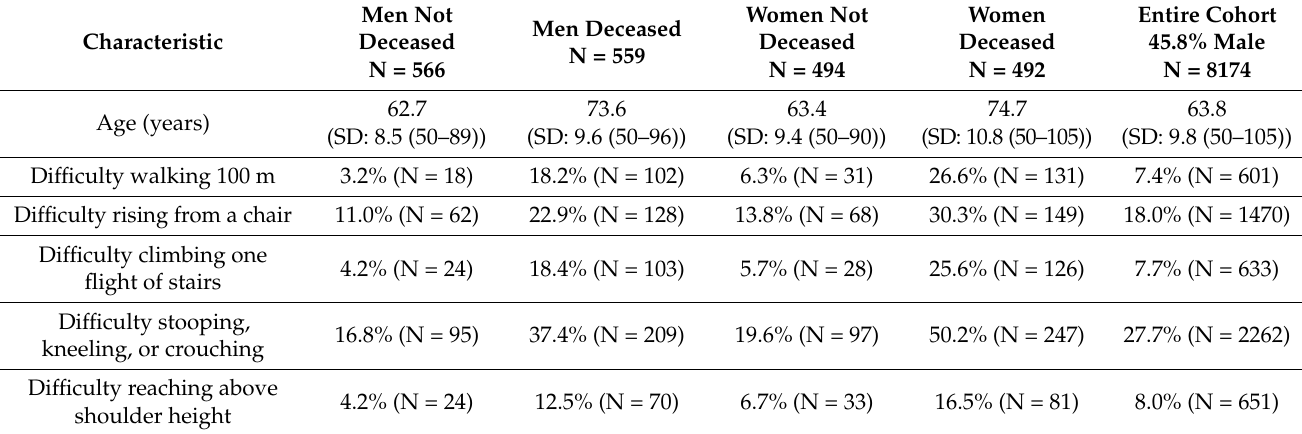
Table 1. Age and FI characteristics of the four balanced groups vis- à -vis those of the entire cohort. Men Characteristic